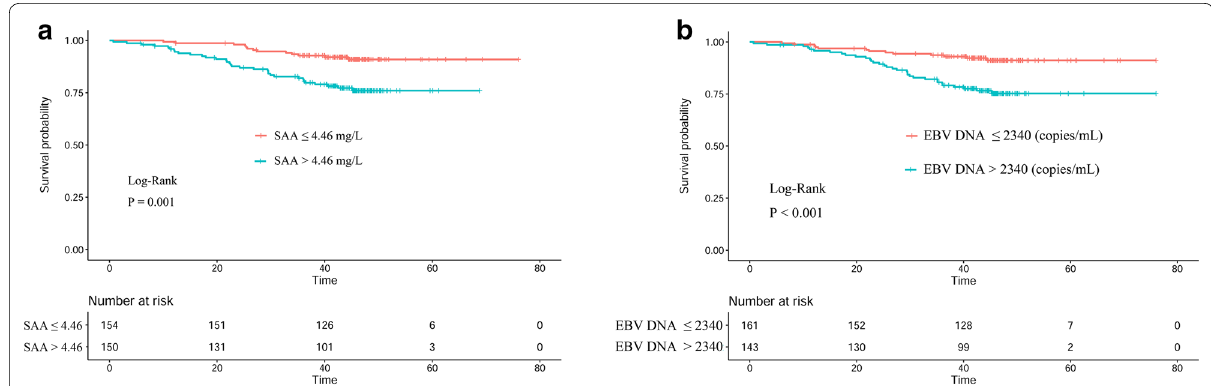
Fig. 1 Kaplan–Meier curves of SAA and EBV DNA for OS in NPC